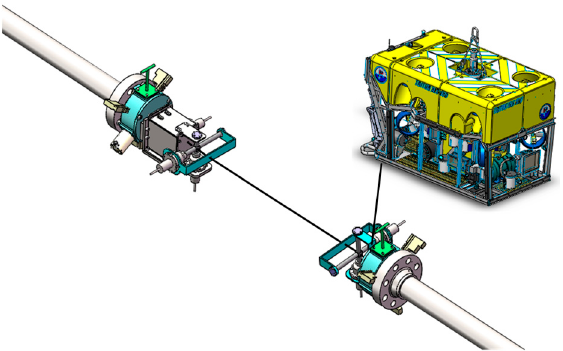
Figure 4. Schematic diagram of the measurement system based on flange center positioning.